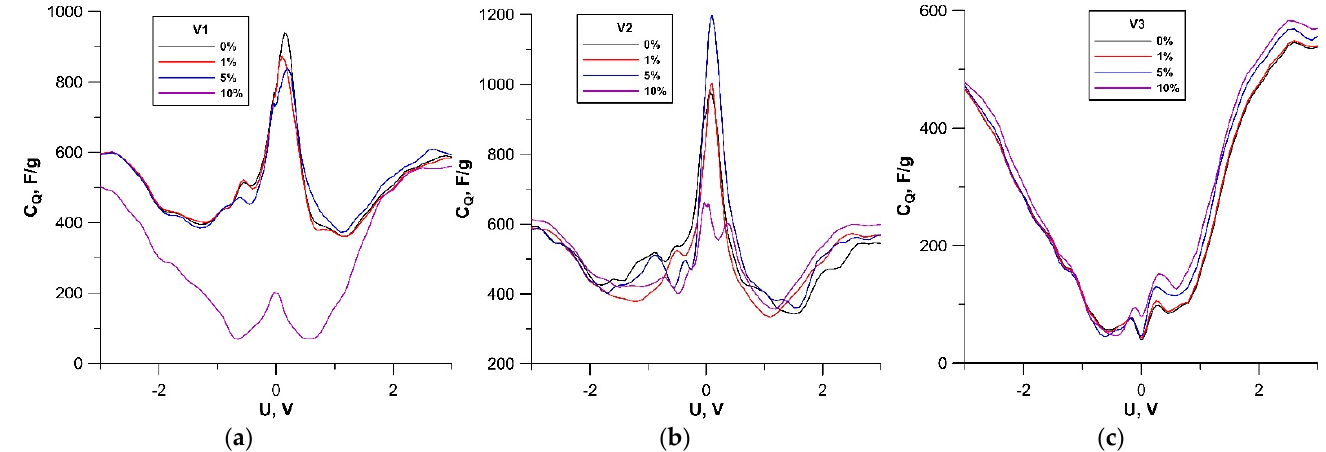
Figure 5. The graphs of the quantum capacitance C Q of hybrid films formed by bilayer graphene and SWCNTs (12, 6) at different stretching strains: ( a ) model V1; ( b ) model V2; ( c ) model V3.